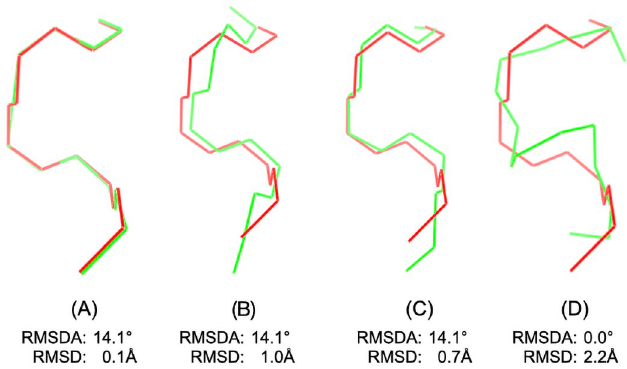
Fig 2. Discrepancy examples between RMSDA and RMSD. Structural alignment of a 5-residue protein fragments (green) against the standard alpha-helical structure (red) with dihedral angles ϕ i = − 57, ψ i = − 47, i = 1, ... , 5. The examples (A)-(C) are chosen such that to highlight that one can find a (green) fragment with the same RMSDA distance value to the reference (red) fragment but varying RMSD. In (D), on the contrary, we show an example of a (green) fragment that has RMSDA of 0 to the reference (red), but a large RMSD. Dihedral angles of the fragment (A) are